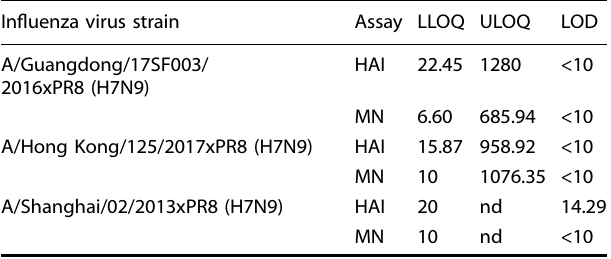
Table 3. Serology assay sensitivity: lower and upper antibody titers that could be determined with acceptable precision and relative accuracy.